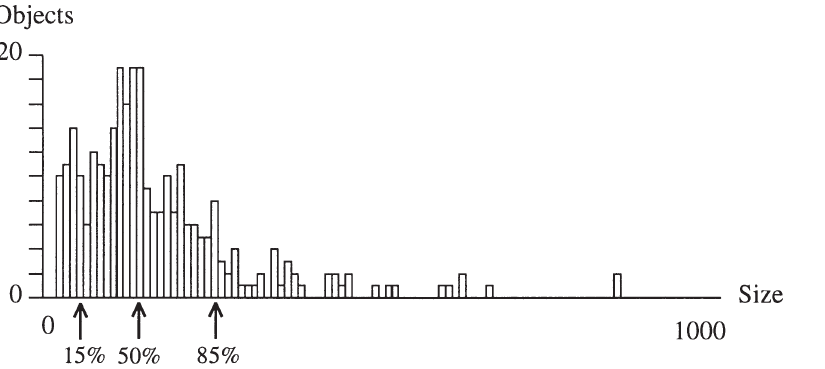
Fig. 2. The frequency histogram of object size for a Grade 1 image. The three percentiles that are used as image features are